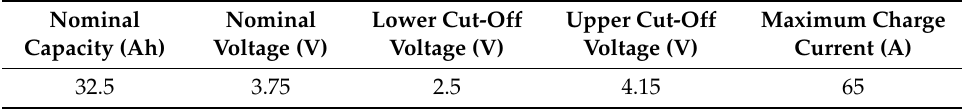
Table 1. Main parameters of the test cell